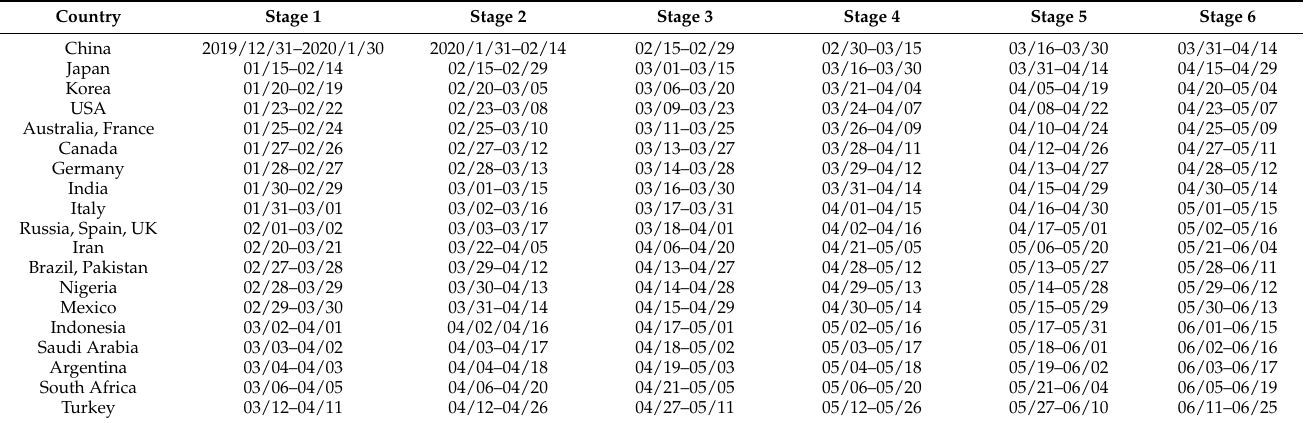
Table 1. The starting and ending dates of each stage for each